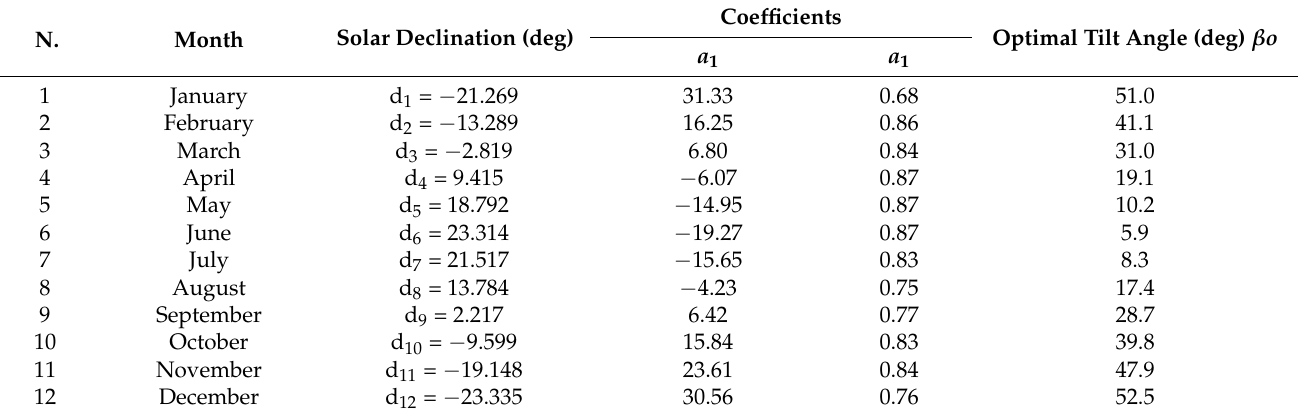
Table 1. Coefficients ( a 1 , a 2 ) according to the solar declination and the optimal tilt angle ( β o ).